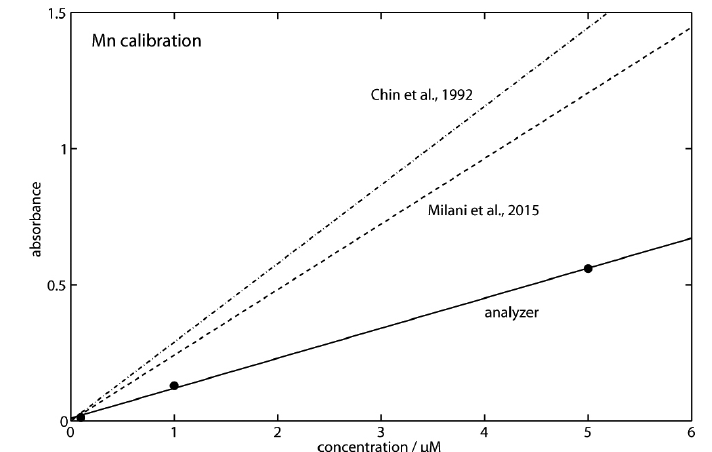
Figure 5. Analyzer calibration lines for dissolved Mn (solid line). Replicate samples (n = 4) were measured for each point. Error bars are within the symbol used for the analyte. The analyzer line is compared to calibrations obtained with other in situ analyzers using the PAN method [33,43]. For comparison purposes, the calibration lines of the other devices are corrected to the analyzer cell length of 14